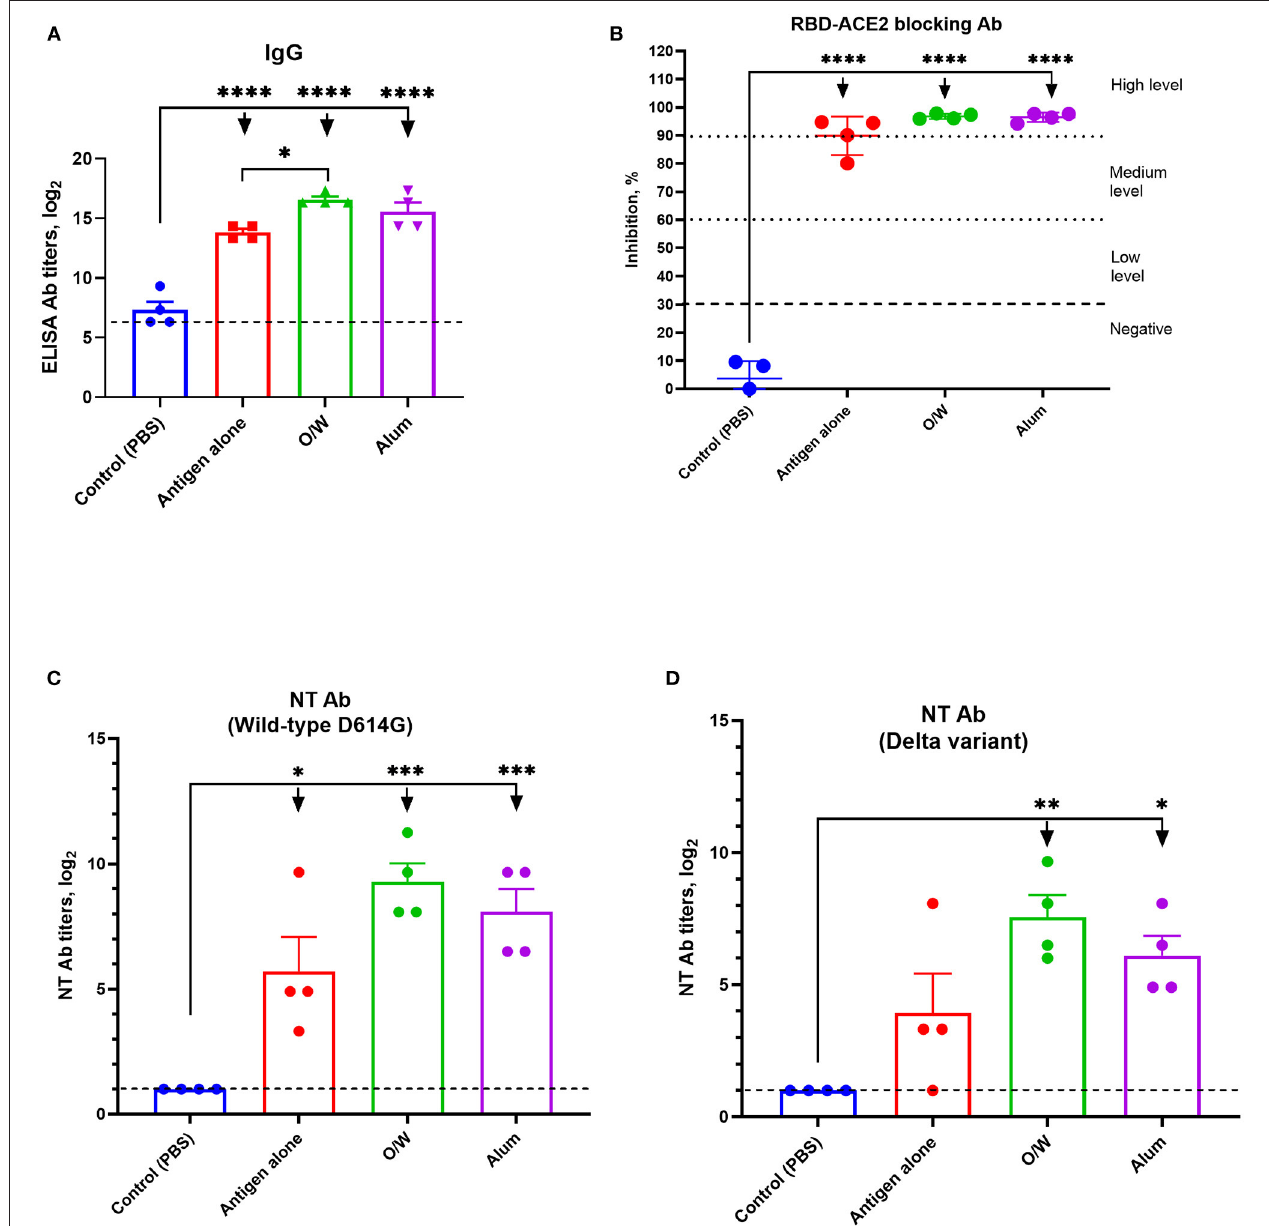
FIGURE 1 | Spike-specific IgG (A) , RBD-ACE2 blocking antibody (B) , and neutralizing antibody (C,D) levels in juvenile cats 14 days after booster immunization. Viral neutralizing antibodies were assessed against wild-type D614G (C) and delta variant (D) viruses. Antigen was used at a dose of 5 µ g with O/W and alum adjuvants. For comparison, 5 µ g antigen was given without adjuvant and a negative PBS control. Differences between groups were assessed using Tukey’s multiple-comparisons test. For all comparisons, P < 0.05 was considered a significant difference. * P < 0.05; ** P < 0.01; *** P < 0.001; and **** P < 0.0001.